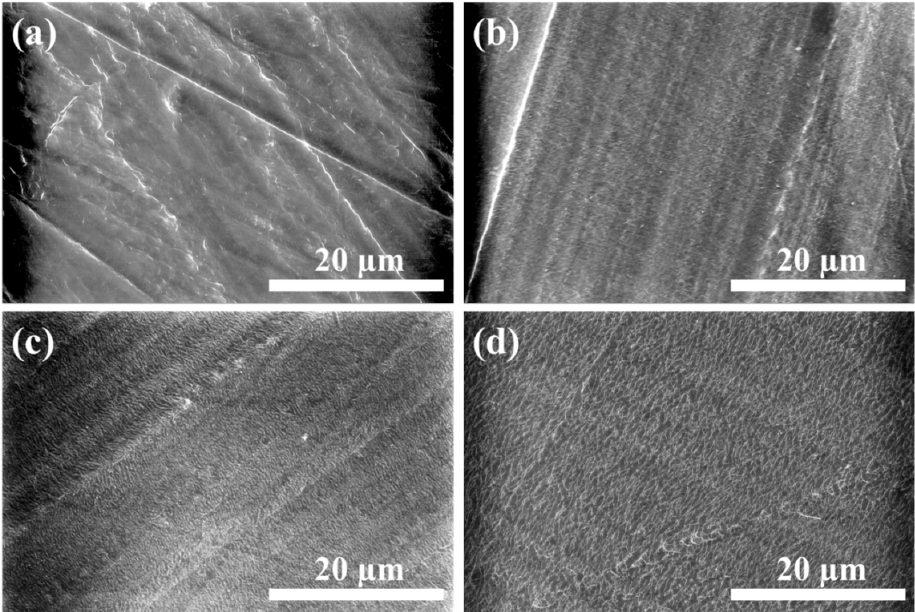
Figure 3. SEM images of UHMWPE film without treatment ( a ), with oxygen plasma treatment for 1 min ( b ), 2 min ( c ) and 5 min ( d